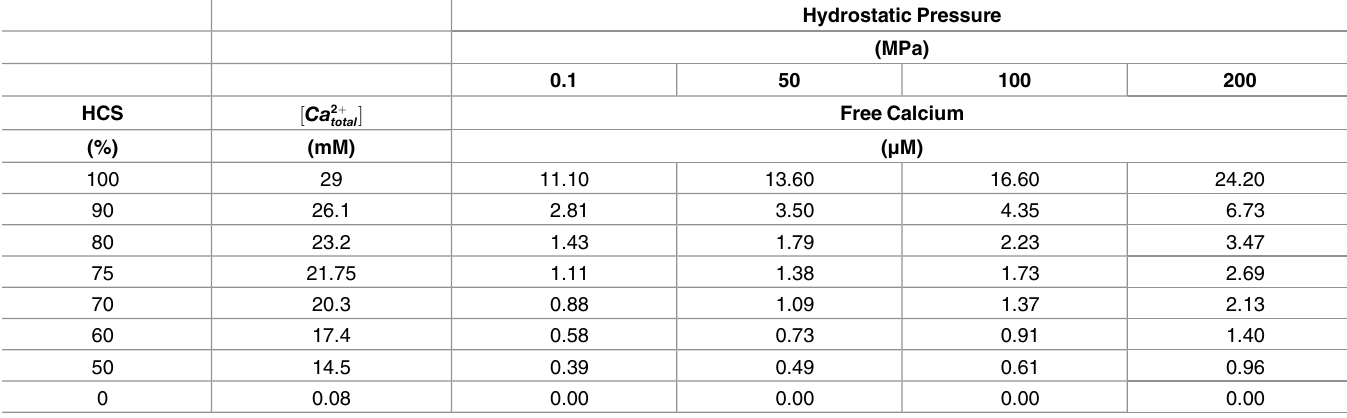
Table 2. Calculated free Ca 2+ ion concentrations at different sample conditions. The values were generated using the software WinMAXC. The Win- MAXC simulations were run at the expected pH conditions at respective pressures (pH changes by 0.847 GPa -1 ). The equilibriumconstants of the NIST database were also adjusted accordingto their expected behaviorunder pressure (logK EGTA changes by -3.6 GPa -1